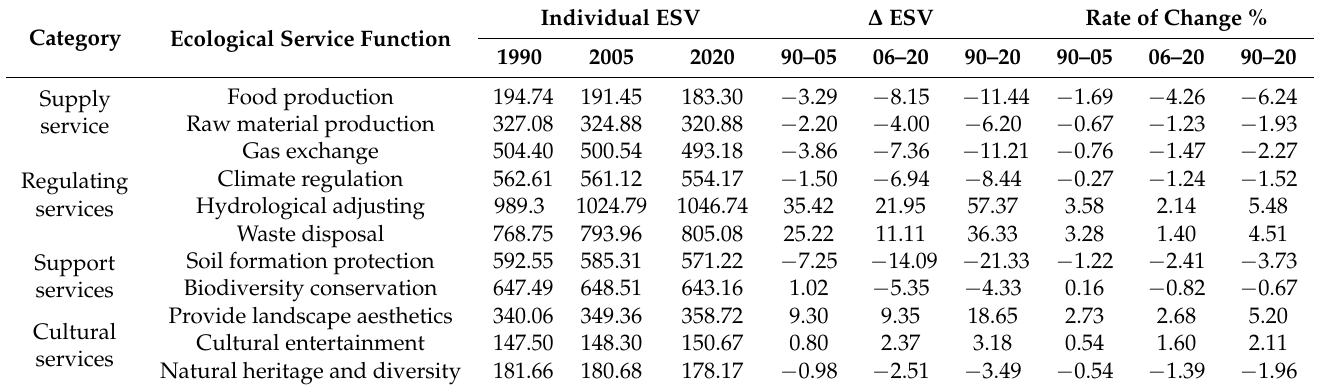
Table 5. Changes of ecosystem service value structure in Wuhan metropolitan area.